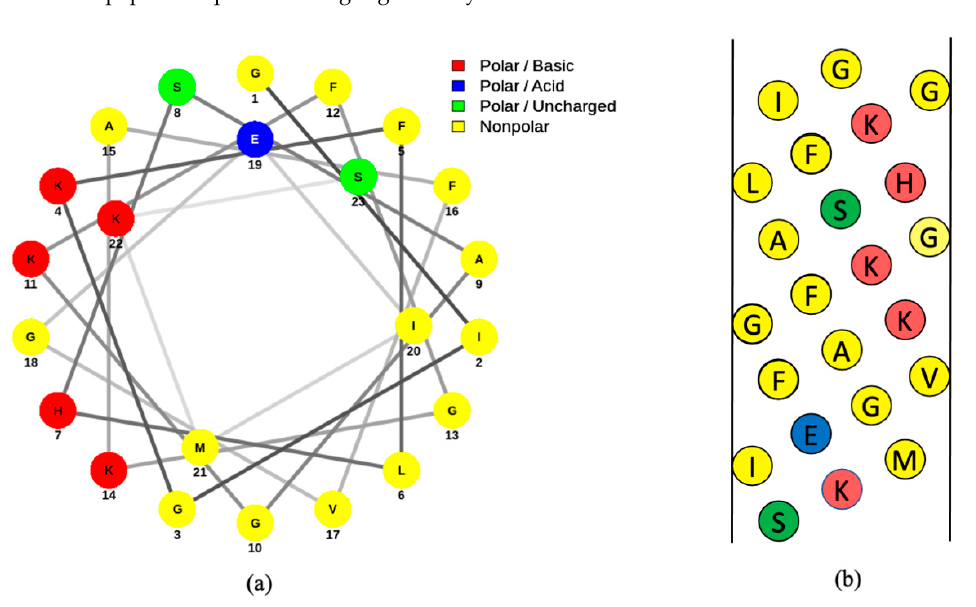
Figure 4. Helical wheel (a) and net diagrams (b) of magainin I [42]. Amino acids are indicated by their single-letter abbreviations and are categorized according to the following colors: polar basic (red), polar acidic (blue), polar uncharged (green), nonpolar (yellow). Both the wheel and net diagrams demonstrate the division of hydrophobic and hydrophilic components of the peptide. The helical wheel diagram was generated using online software called NetWheels [43] and the net diagram was made using Microsoft PowerPoint.